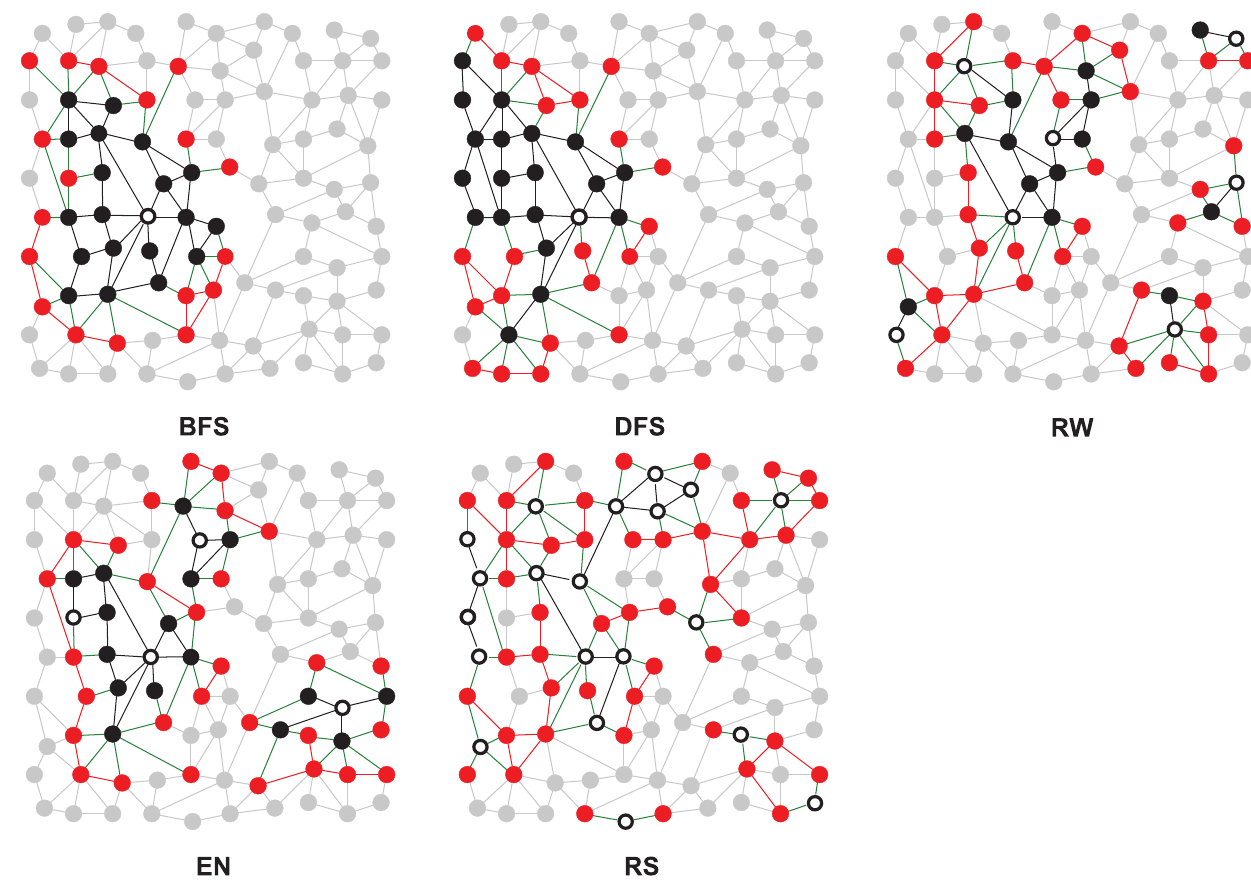
Figure 3. Membership propagation in a toy example according to different propagation models. Note that real social networks exhibit more long-range edges. Examples for the platform penetration value r ~ 0 : 2 show the nodes from which the propagation started (black nodes with white core). Other members are marked black and relevant non-members red; for ease of reading arrows are not displayed, but black edges are bidirectional while green edges point from black to red nodes. With BFS and DFS the network is explored starting from one node (denoted by a white circle); with RW and EN there are more nodes from which the propagation is launched; and finally, for RS all selected nodes can be seen as starting nodes.